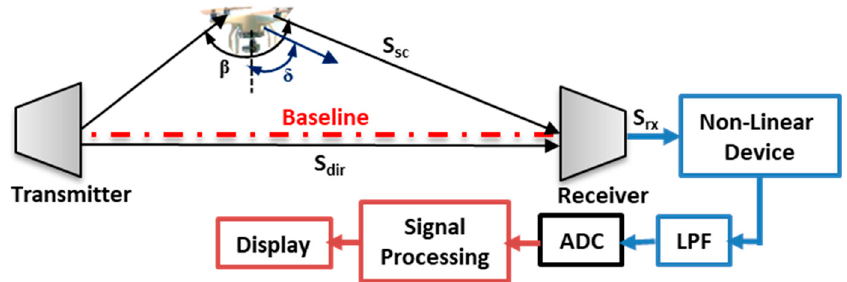
Figure 1. FSR (Forward Scattering Radar) geometry with receiver setup for drone detection. The receiver includes Low Pass Filter (LPF) and Analogue to Digital (ADC).